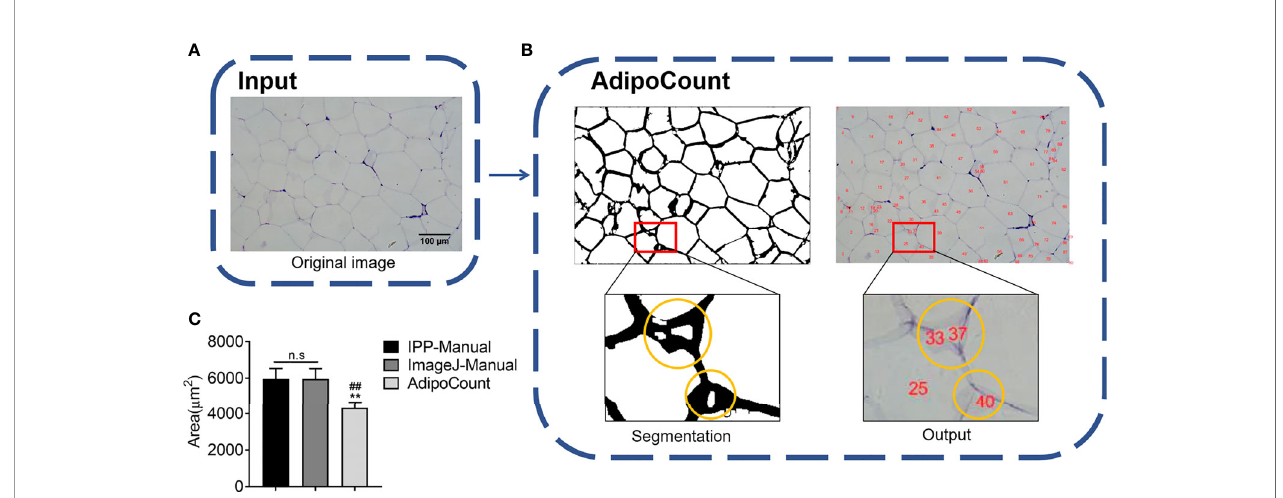
FIGURE 2 | AdipoCount cannot recognize empty holes, cell debris, and adhesion edges. (A) Original image of adipocytes. (B) The segmentation image of AdipoCount (left), and the labeled image with cell numbers (right); what in the yellow circles were cell debris or empty holes (left), which were counted as cells mistakenly by AdipoCount (right). (C) Adipocyte sizes measured by manual methods with IPP and ImageJ, or calculated with AdipoCount. Data are presented as mean ± SEM and **P < 0.01 compared to IPP manual measurement group. ## P < 0.01 compared to ImageJ manual measurement group. n.s., not signi fi cant; IPP, Image-Pro